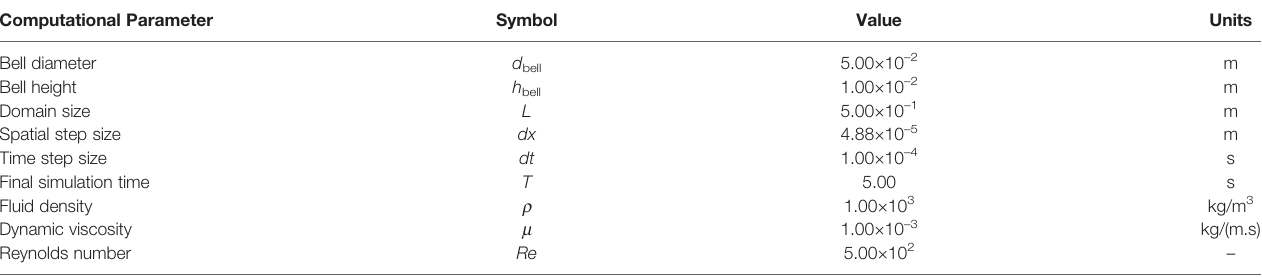
TABLE 2 | The parameters for the numerical simulations of upside-down jelly fi sh. Computational Parameter